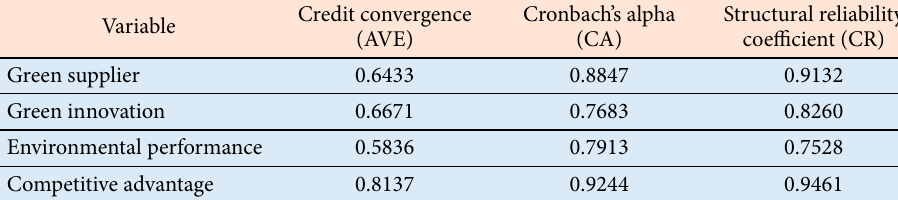
Table 1. Results of measuring the reflection models